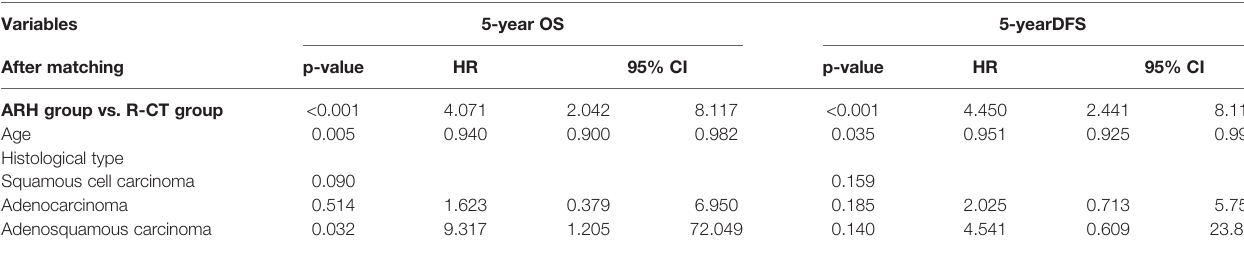
TABLE 3 | COX multifactor analysis of matched